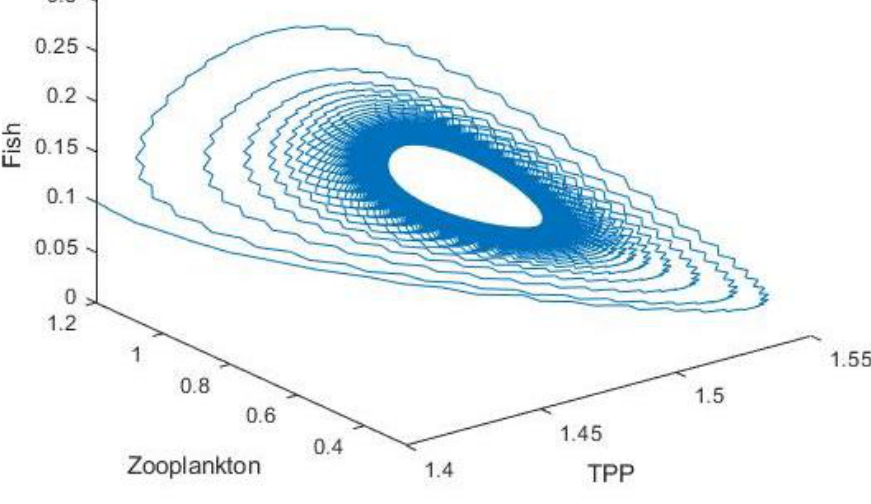
Figure 28. Equilibrium of all populations loses its stability for τ = τ +